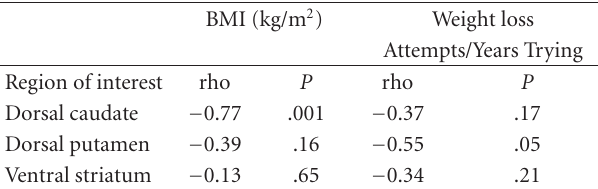
Table 1: Spearman Correlation Coe ffi cients for FMT Uptake versus BMI (kg/m 2 ) and versus Weight Loss Attempts/Years Trying.